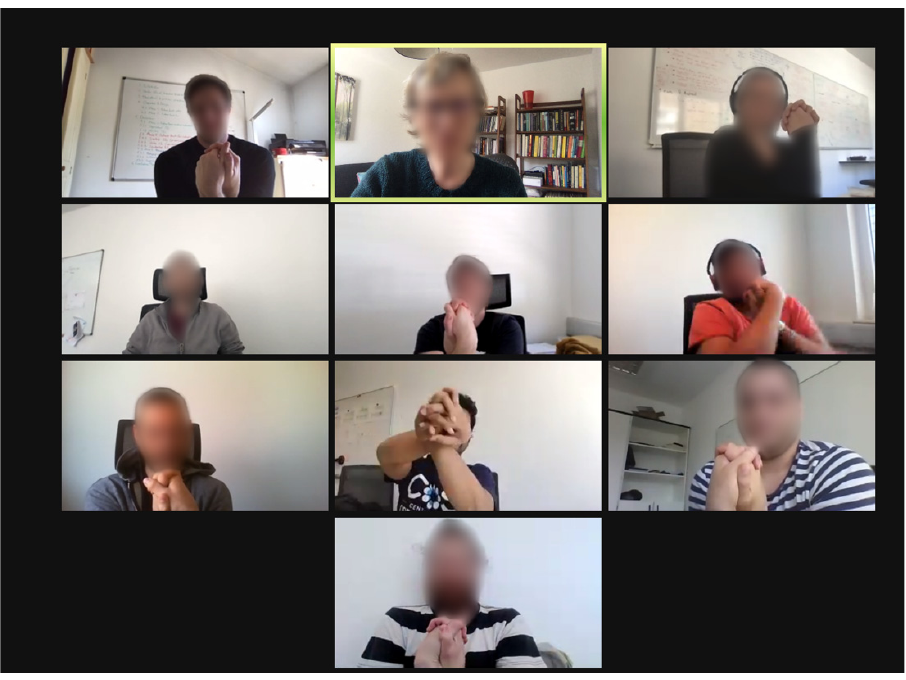
Figure 5. Screenshot of participants using the ‘proxy feeler’ method with the Skin boundaries Disruptive Probe.